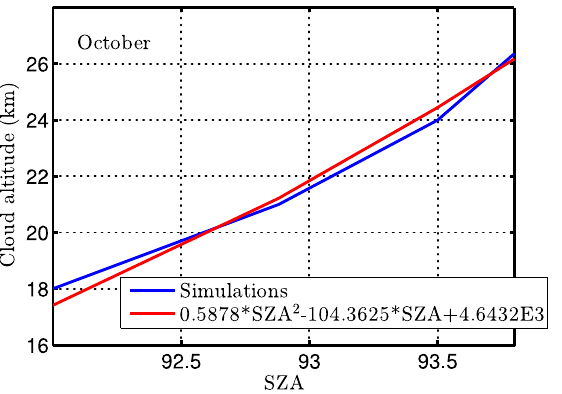
Figure 10. Variation of the SZA of maximum CI with the cloud altitude in the UV spectral range. This curve was computed for λ 1 = 401 nm and λ 2 = 332.5 nm, a cloud opacity τ PSC = 0.2, and the gas profiles illustrated in Figure 4 for the month of October. Simulations are shown in blue and the polynomial fit of the observations in